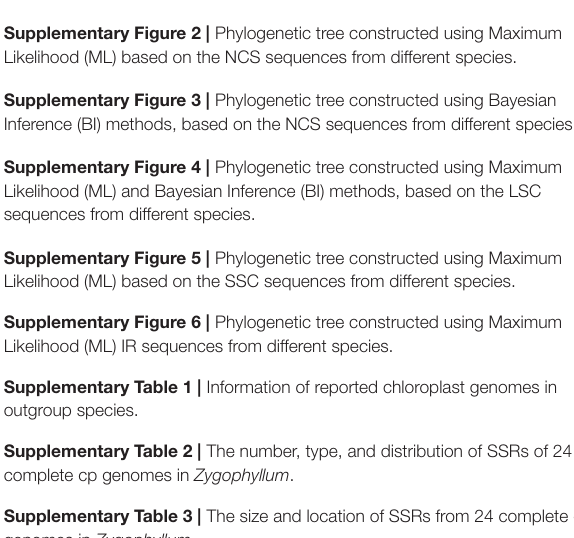
Supplementary Figure 2 | Phylogenetic tree constructed using Maximum Likelihood (ML) based on the NCS sequences from different species. Supplementary Figure 3 | Phylogenetic tree constructed using Bayesian Inference (BI) methods, based on the NCS sequences from different species. Supplementary Figure 4 | Phylogenetic tree constructed using Maximum Likelihood (ML) and Bayesian Inference (BI) methods, based on the LSC sequences from different species.